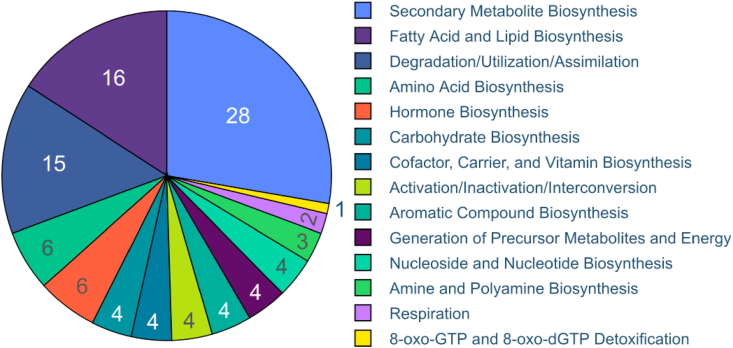
Pie-chart depicting distribution of different classes of metabolic pathways across all modules extracted from the MFSN. This diagram shows that the Secondary Metabolite Biosynthesis, Fatty Acid and Lipid Biosynthesis and Degradation/Utilization/Assimilation pathways are three major metabolic classes that are targeted by pairwise or synergistic miRNA pairs extracted from the MFSN module.